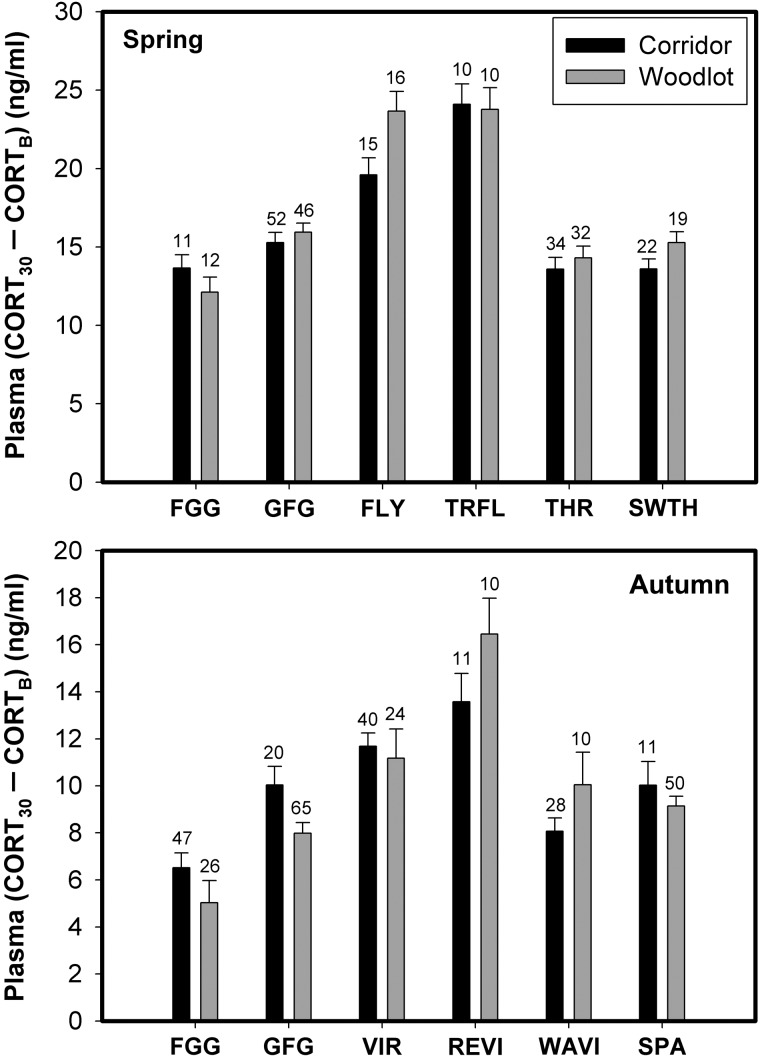
Mean (±SEM) magnitude of the stress response (CORT30 − CORTB, in nanograms per millilitre) for spring and autumn individual species, taxa and foraging guilds. Abbreviations are as in Tables 1 and 2.